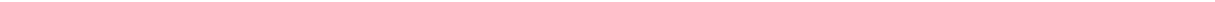
Fig. 9 Exacerbation of WAT browning by a miR-327 inhibitor. a Histological analysis of adipocyte morphology (H&E), adipocytes (PERI), mitochondria (COX4) and uncoupling protein 1 (UCP1) in Inh-miR-NC- and Inh-miR-327-treated 2-week 30 °C and 2-week 4 °C-exposed scWAT. Double-headed arrows mark adipocyte diameter. Arrows point to respective positive signals. b – d Quanti fi cations of adipocyte size and positive signals of COX4 and UCP1 in Inh-miR-NC- and Inh-miR-327-treated 2-week 30 °C and 2-week 4 °C-exposed scWAT ( > 30 adipocytes per fi eld; n = 10 random fi elds; n = 4 mice per group). e – h Western immunoblot analysis and quanti fi cation of FGF10 and UCP1 in Inh-miR-NC- and Inh-miR-327-treated 2-week 30 °C and 2-week 4 °C- exposed scWAT. FGF10 and UCP1 protein levels were quanti fi ed as densitometric signals and normalized to β -actin ( n = 4 samples per group). i scWAT weight of C57BL/6 mice receiving Inh-miR-NC or Inh-miR-327 treatment under 2-week 30 °C or 4 °C exposure ( n = 6 mice per group). j , k Oxygen consumption of Inh-miR-NC- and Inh-miR-327-treated C57BL/6 mice after 2-week 30 °C or 4 °C exposure ( n = 6 mice per group). l Norepinephrine- stimulated thermogenesis of Inh-miR-NC- and Inh-miR-327-treated C57BL/6 mice after 2-week 30 °C and 2-week 4 °C exposure. Oxygen consumption is presented as area under curve (AUC) ( n = 4 mice per group). Scale bars, 100 μ m. kDa, kilodalton. NS, not signi fi cant. * P < 0.05, ** P < 0.01, and *** P < 0.001 by Student ’ s t -test. Data presented as mean ±